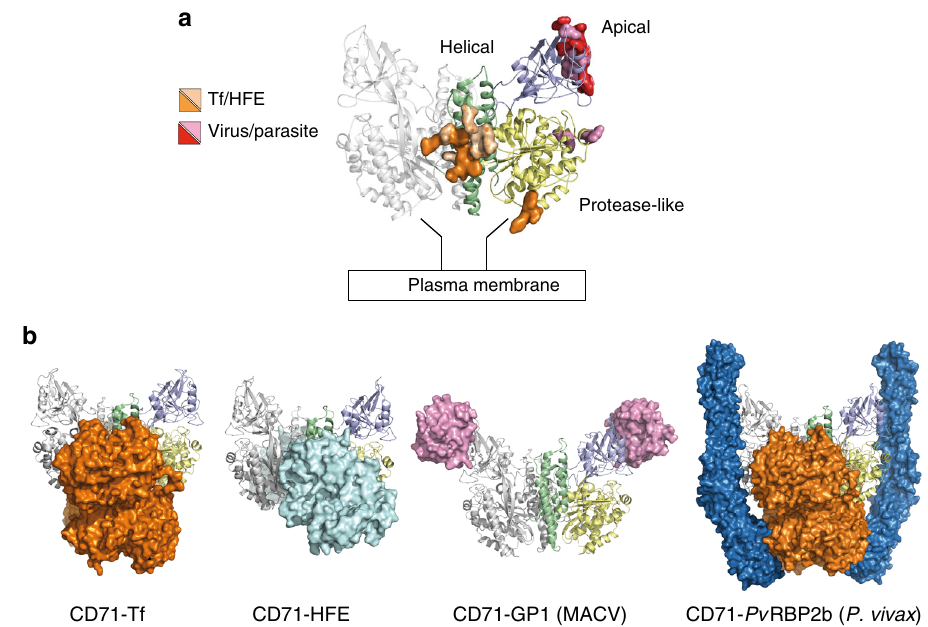
Fig. 1 CD71 receptor: ligand recognition epitopes and binding modes. CD71 homodimer is shown in ribbon representation (pdb 3KAS 8 ). One monomer is in light gray, the other is colored variably to the receptor domains (apical, light blue; protease-like, yellow; helical, green). a CD71 residues identi fi ed as recognition epitopes for Tf/HFE and viruses/parasite are represented as orange/wheat and red/pink surfaces, respectively. b CD71 receptor is shown bound to Tf (orange surface, pdb 1SUV 14 ), HFE (cyan surface, pdb 1DE4 17 ), GP1 protein of MACV (pink surface, pdb 3KAS), and Tf (orange surface) and Pv RBP2b from P. vivax (blue surface, pdb 6D04 12